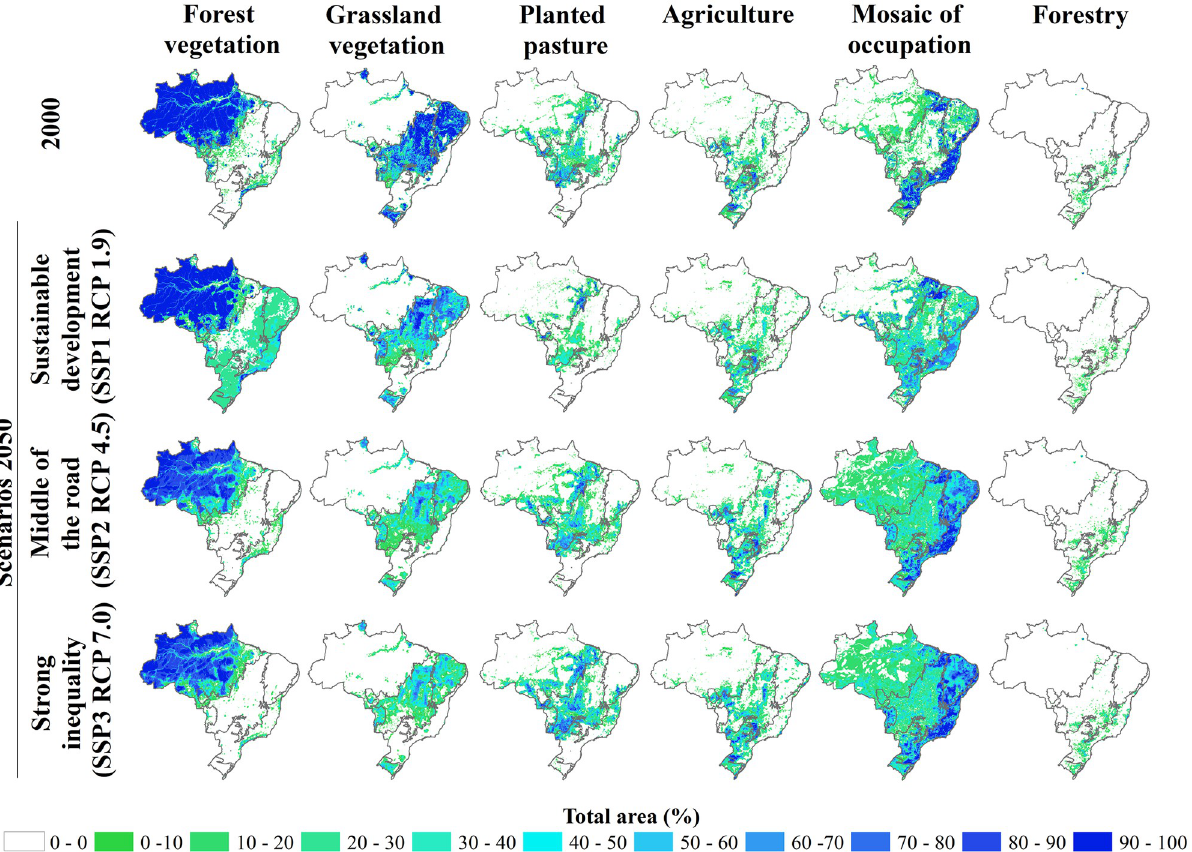
Fig 6. Spatial distribution of areas and land use according to the scenarios from 2000 to 2050. The source of States boundaries is according to IBGE [31].